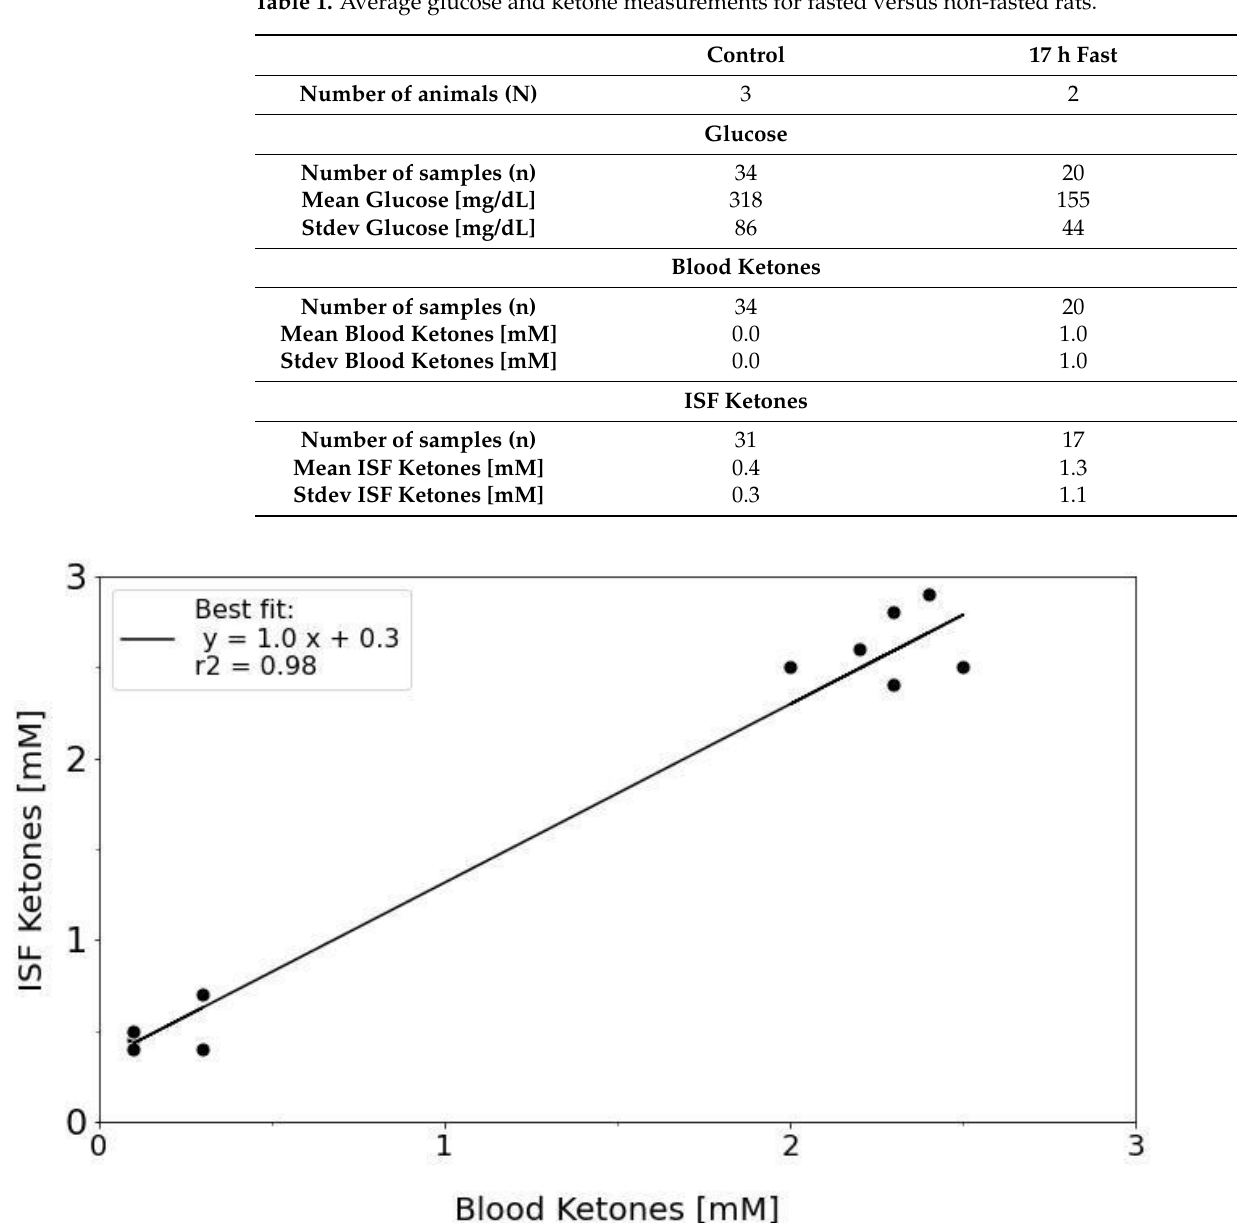
Figure 5. ISF and blood ketone correlation for fasted (17 h) CD hairless rats (N = 2). Dots show the ISF/Blood measurements whereas the black line shows the best linear fit line. The linear fit equation and r 2 values are shown in the top left corner of the figure.